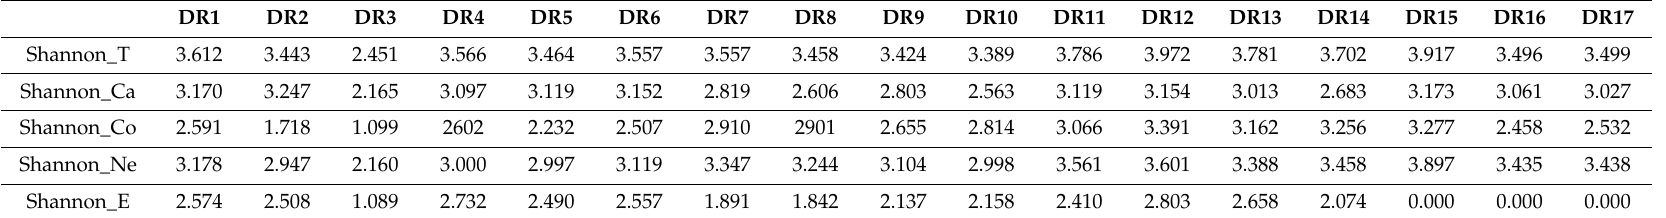
Table 4. Shannon diversity by 17 relev é from Dominican Republic (DR).